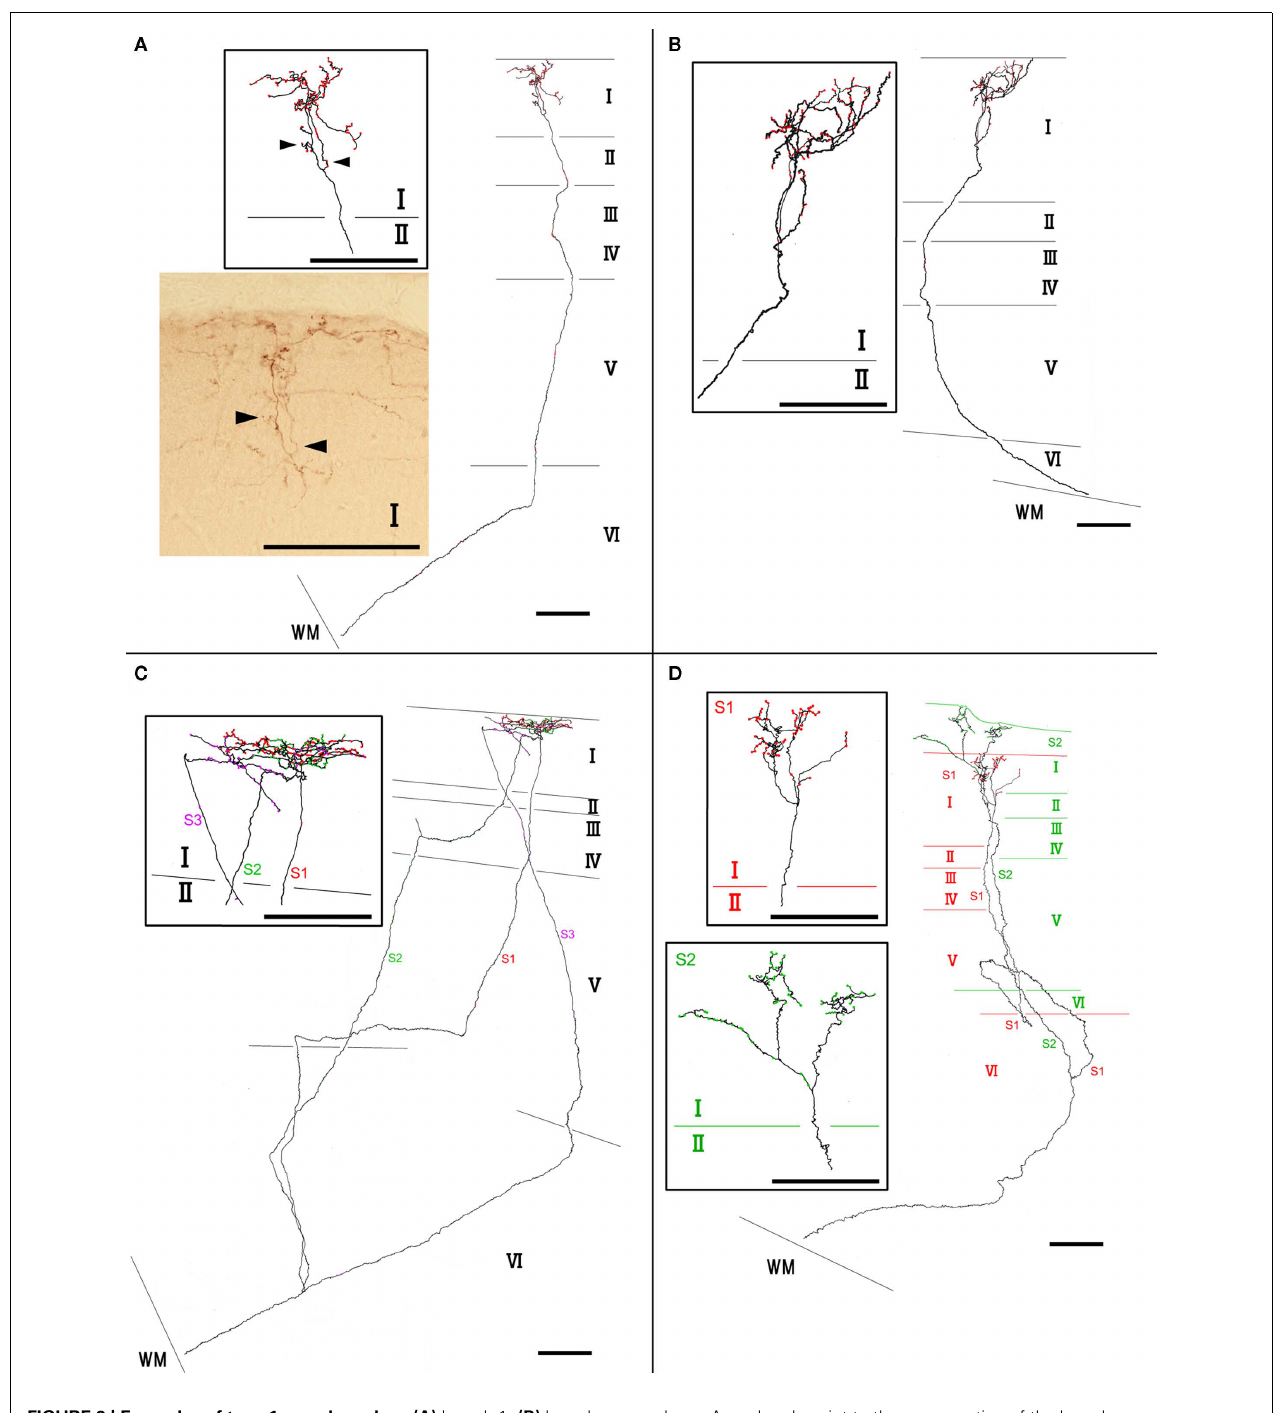
FIGURE 2 | Examples of type 1 axon branches. (A) branch 1; (B) branch 2; (C) branch 6; (D) branch 7. Red dots on axons represent boutons. Insets within rectangles are enlarged images, mainly in layer I of each branch. Photographic inset in (A) is from a single section of the branch inset